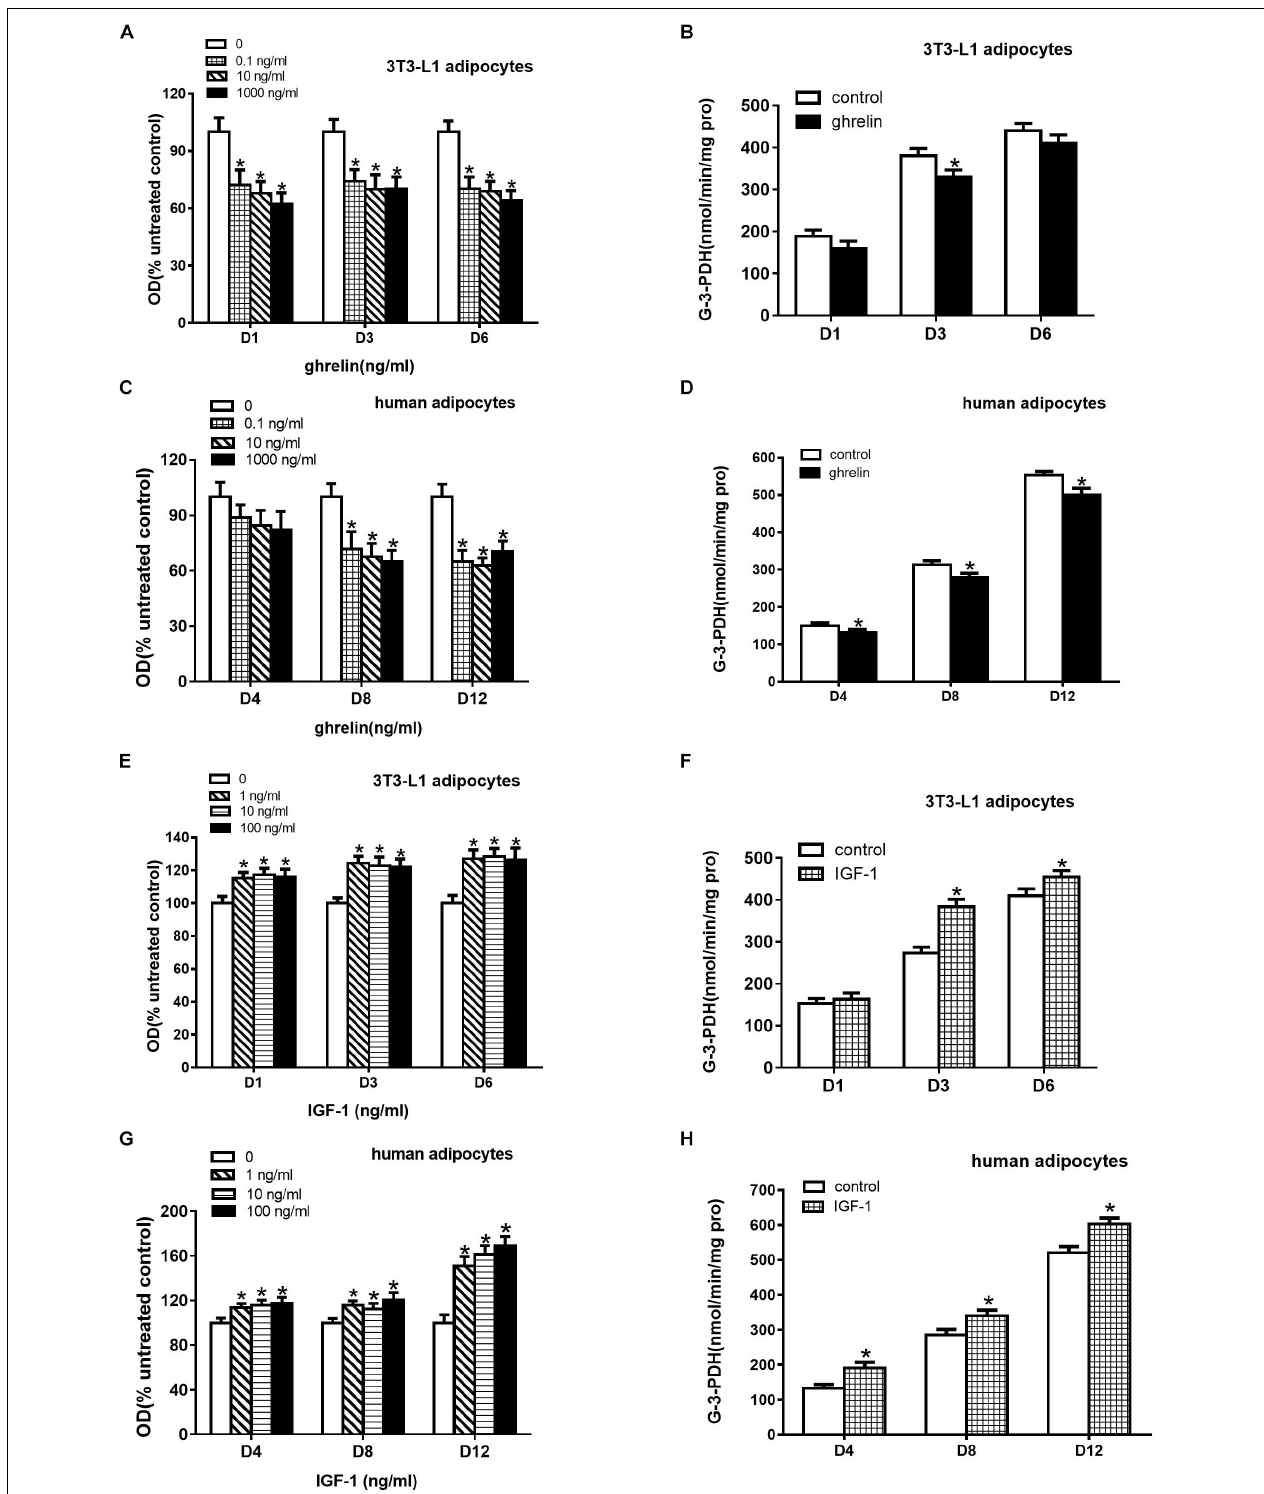
FIGURE 5 | Ghrelin suppressed while IGF-1 stimulated the differentiation of 3T3-L1 and human primary preadipocytes. Differentiation was measured based on Oil Red O staining revealing triglyceride (A,C,E,G) and G-3-PDH activity (B,D,F,H) . Preadipocytes were treated with ghrelin (A–D) and IGF-1 (E–H) . The data are presented as the mean ± SD for three independent experiments with eight (A,C,E,G) or three (B,D,F,H) individual wells in each experiment. ∗ p < 0.05 vs. control group.